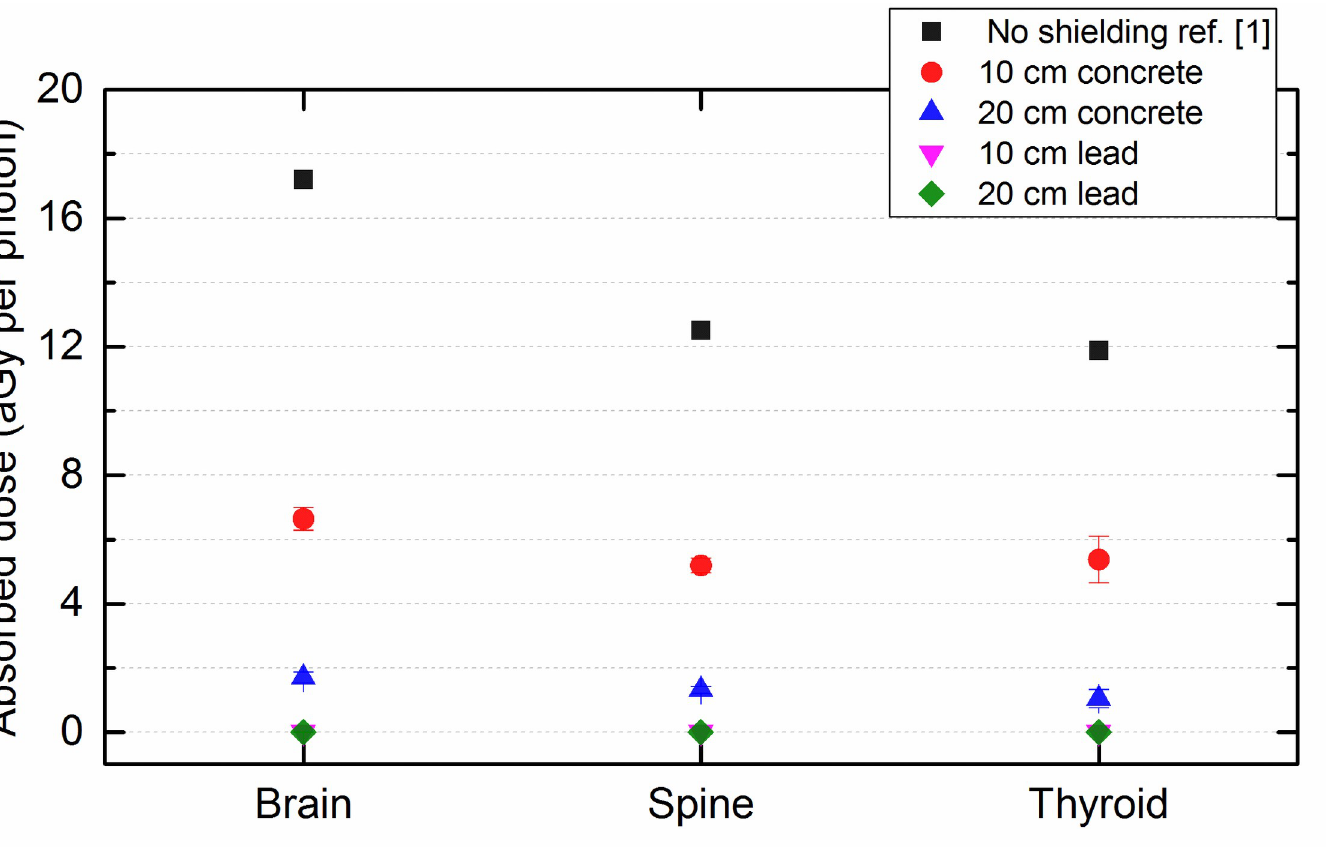
Fig 3. Absorbed photon dose per photon in the brain, spine and thyroid of the adult male phantom for no shielding, 10 and 20 cm thick concrete and lead shielding. The error bars represent the statistical uncertainties associated with Monte Carlo simulation. Some of the error bars are smaller than symbols.